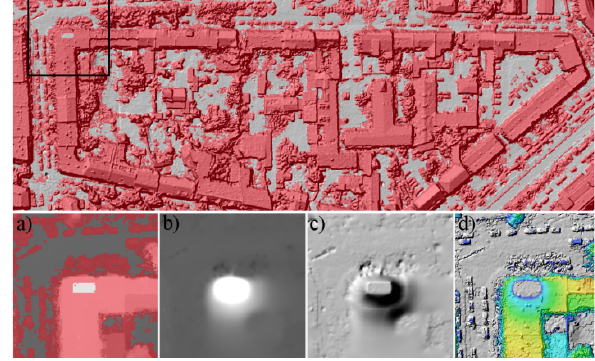
Figure 12. False negatives in the elevated mask cause errors in the final DTM and nDSM 8